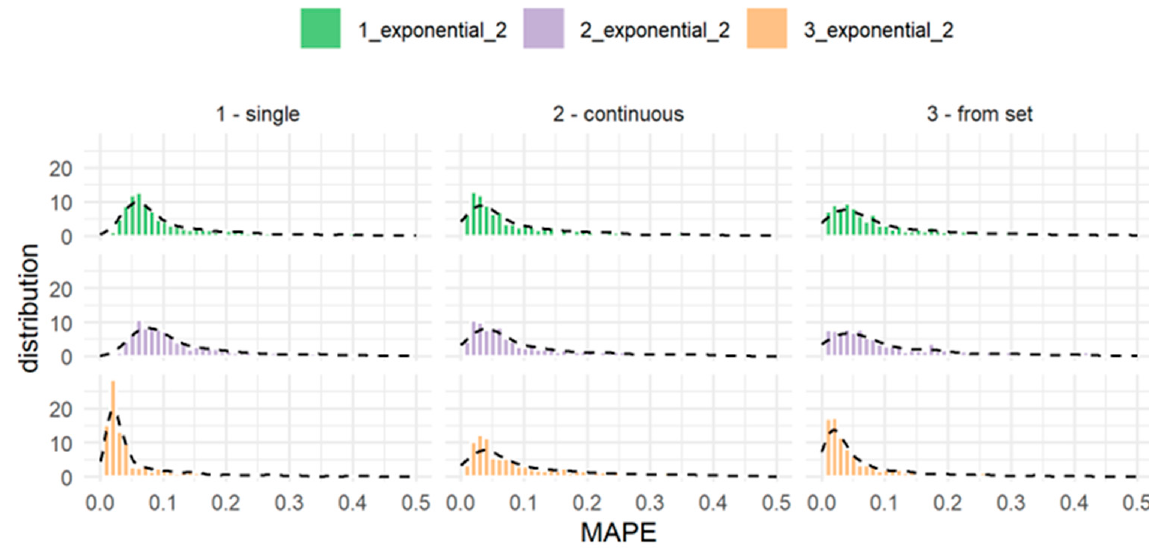
Figure 8. MAPE error distribution. Source: own elaboration.